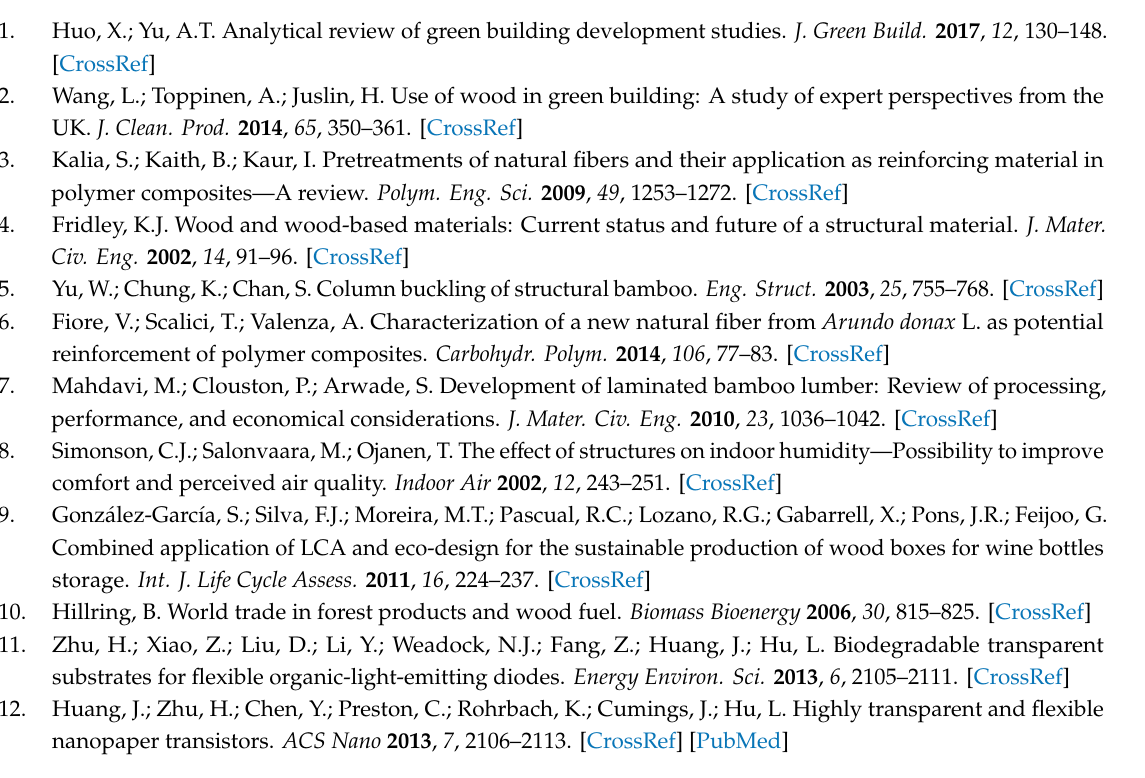
Figure S1: XPS, Figure S2: Mechanical properties, Figure S3: Interfacial fracture energy, Table S1: Interfacial fracture energy improvements, Video S1: Burning